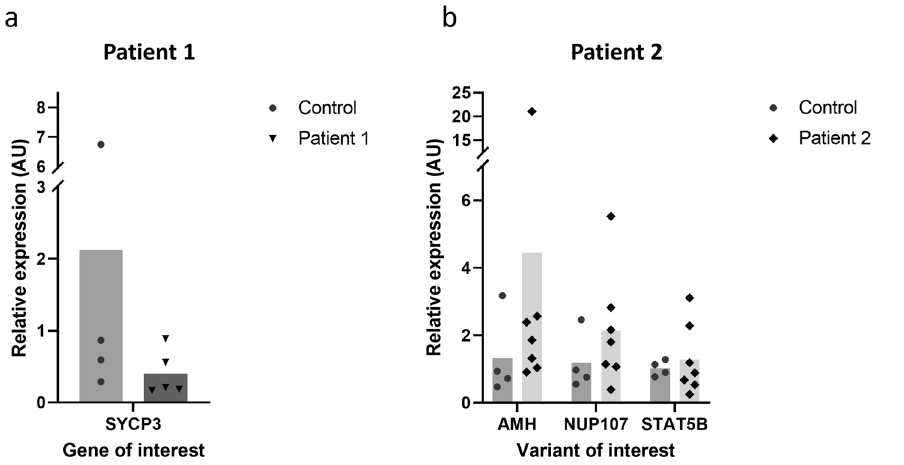
Figure 5. RT-qPCR analysis of candidate genes on embryoid bodies. ( a ) SYCP3 expression level in patient 1 compared to 46,XX control cells. ( b ) AMH, NUP107 and STAT5B expression levels in patient 2 compared to 46,XX control. Histograms represent mean from independent biological replicates represented by each point. Gene expression was normalized to RPLPO. Mann–Whitney tests were used for PCR analysis. AMH anti- Müllerian hormone, NUP107 nucleoporin 107, STAT5B signal transducer and activator of transcription 5B, SYCP3 synaptonemal complex protein